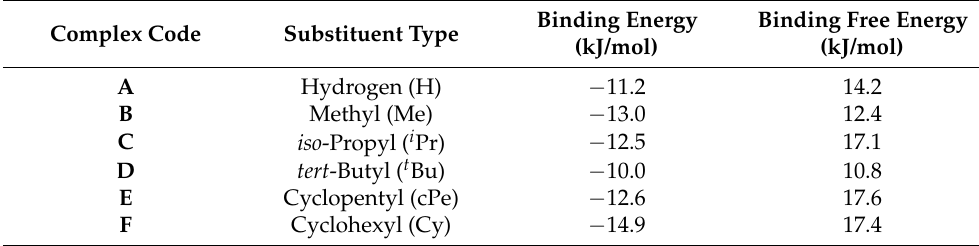
Table 1. Binding energy and binding free energy for CO 2 coordination on Ru-PNP complexes with different substituents.